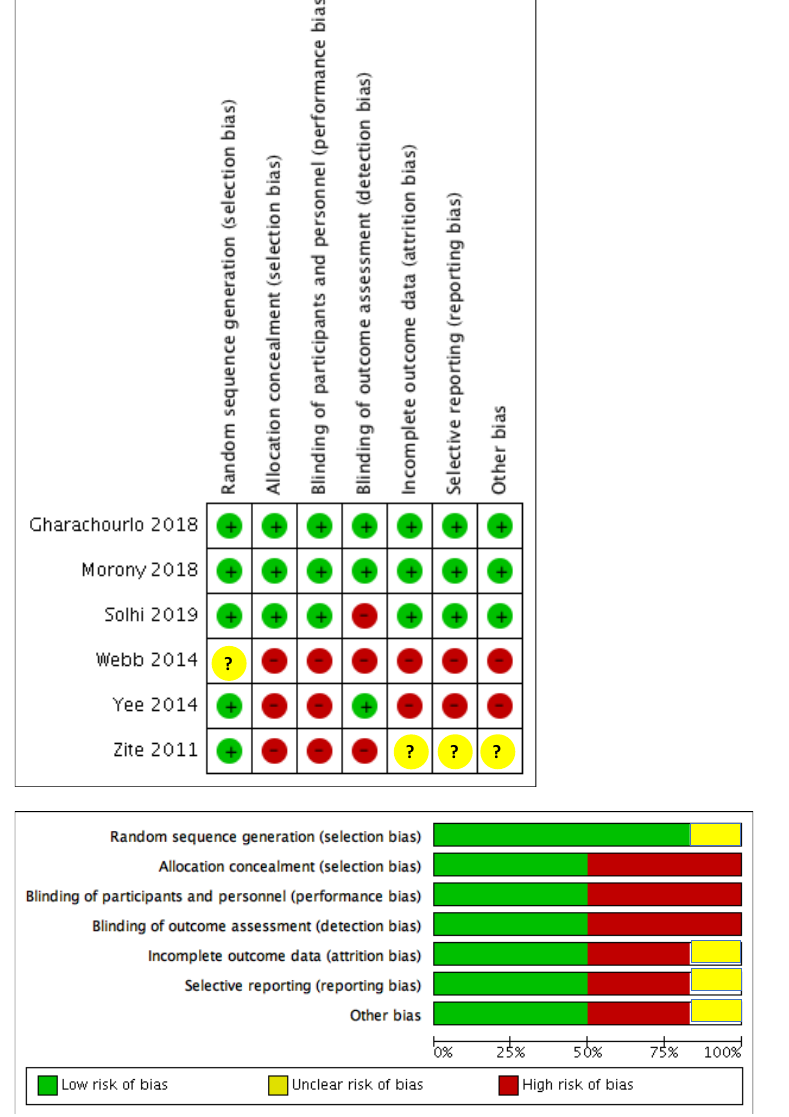
Figure 2. Risk of bias of the included